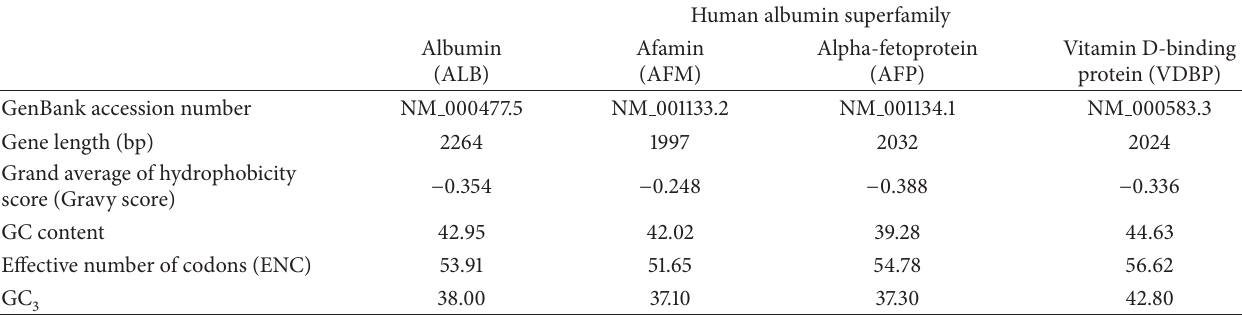
Table 1: Genomic information of the reference sequences, grand average hydrophobicity score, ENCs, GC content, and GC 3 of human albumin superfamily members.